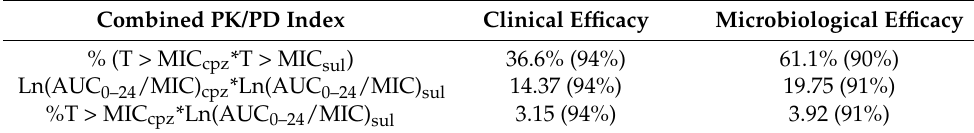
Figure 3. Correlation between the combined PK/PD index and clinical ( A ) or microbiological efficacy ( B ). The p -value of the slope obtained from logistic regression for clinical or microbiological efficacy were 0.047 and 0.114, respectively. cpz: cefoperazone; sul: sulbactam. Table 5. Target for the combined PK/PD index against infection by